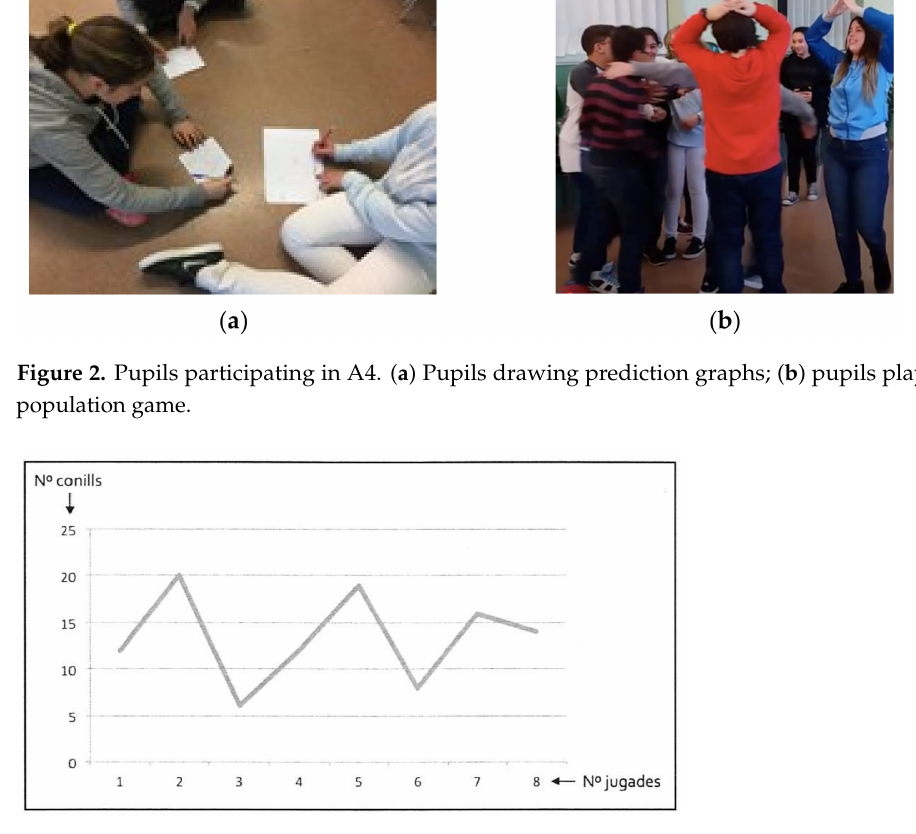
Figure 3. Graphic representation provided to the pupils after the simulation in